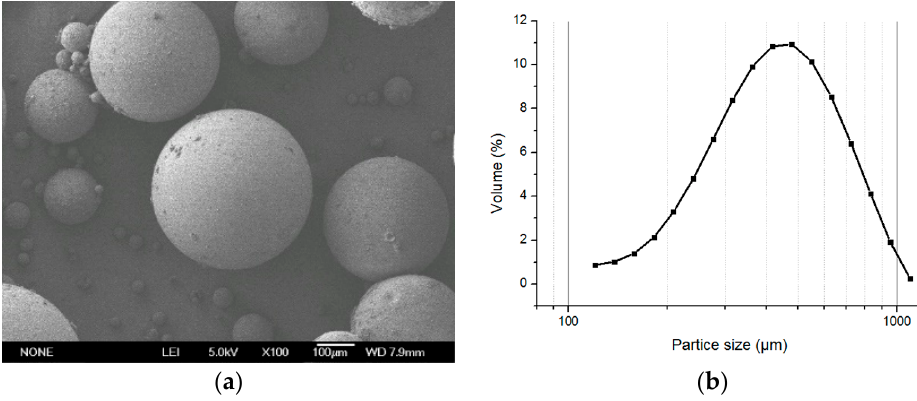
Figure 6. ( a ) The SEM photographs of the microspheres with stirring speed 70 rpm, swelling time 5 min, (×100) and ( b ) size distribution. Table 3. The relationship between stirring rate/ swelling time and particle size.